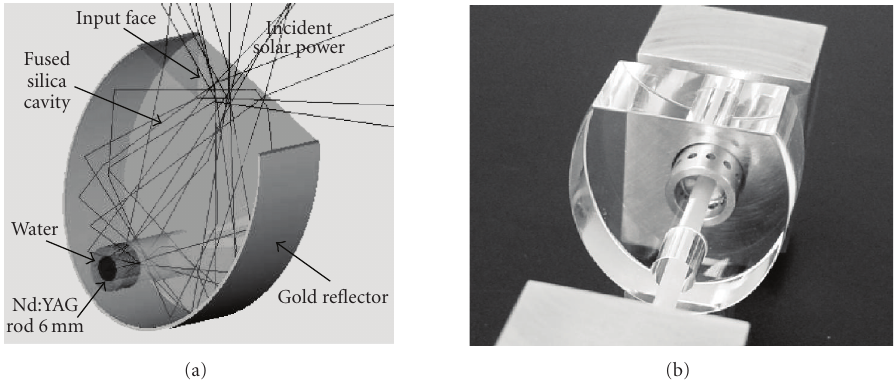
Figure 4: (a) Three-dimensional view of the truncated cavity (only 10 trace rays are illustrated in the figure). (b) Apreliminary experimental setup of the truncated cavity is shown. Both the curved elliptical surface and the side faces are still uncoated.